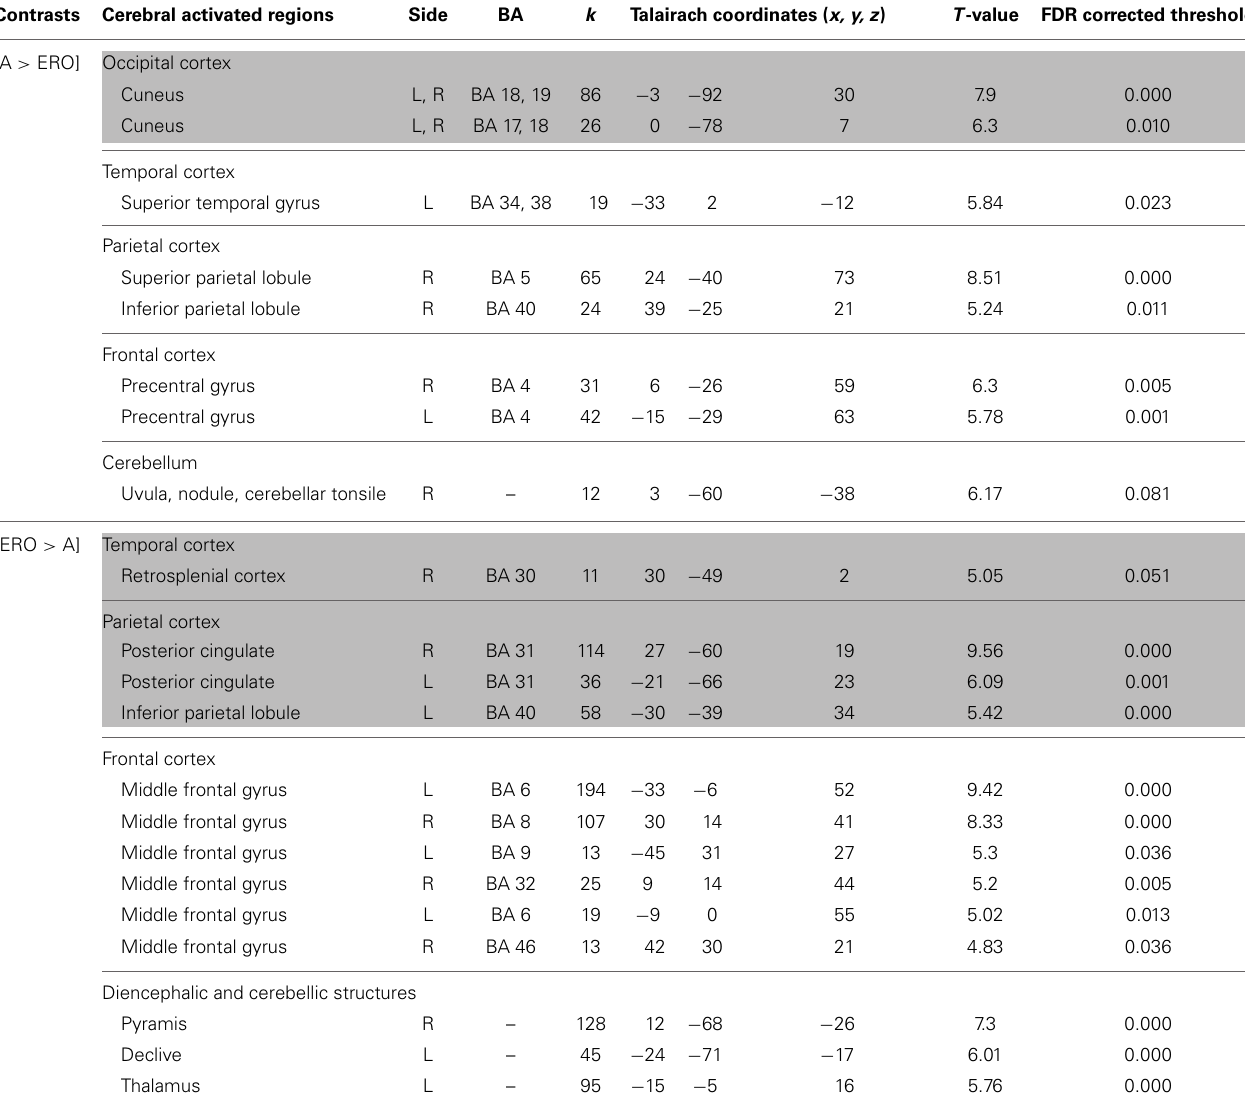
Table 5 | Activated regions provided by the contrast: (1) A vs. ERO for the upper part of the table; (2) ERO vs. A for the lower part of the table (random-effect analysis, uncorrected p < 0 . 001, k ≥ 10 voxels).